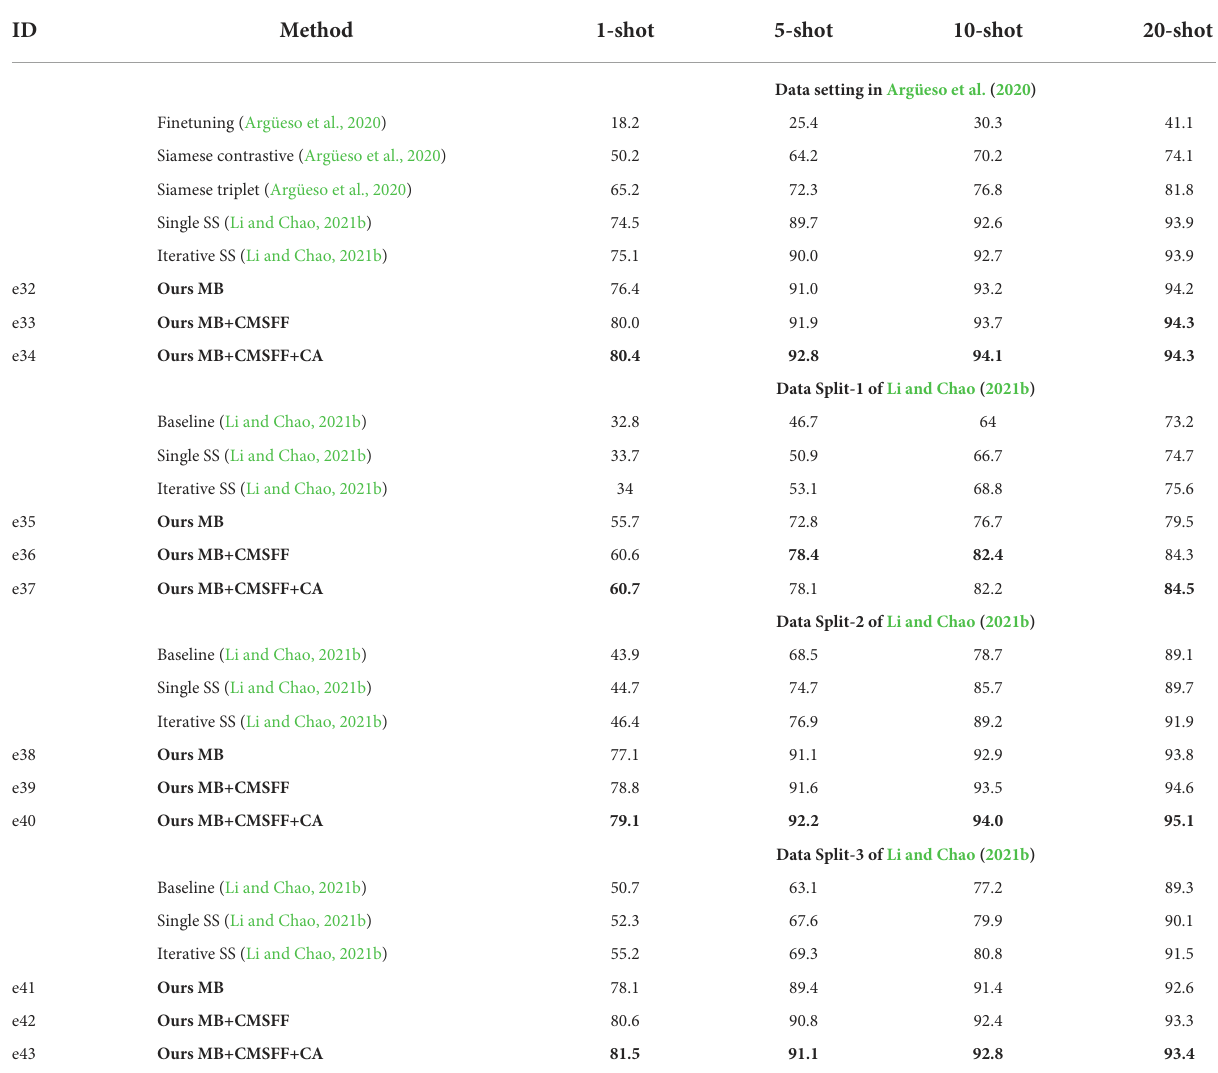
TABLE 9 The results compared with related